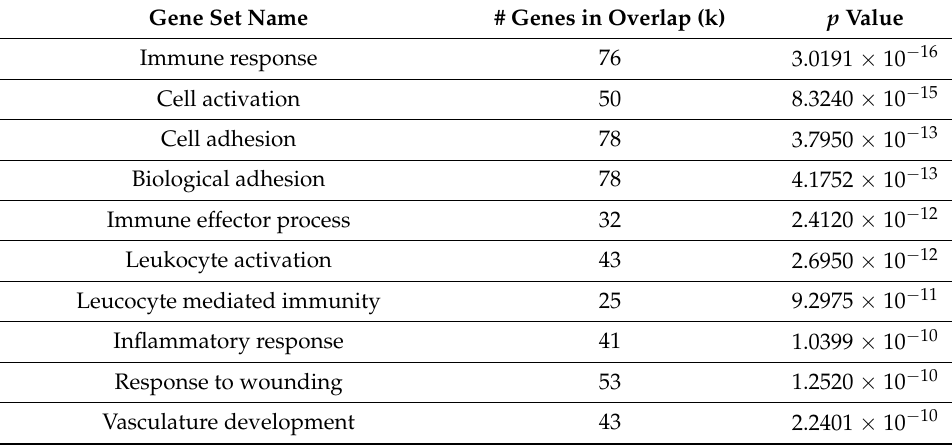
Table 3. Top ten biological processes from Gene Ontology (GO)